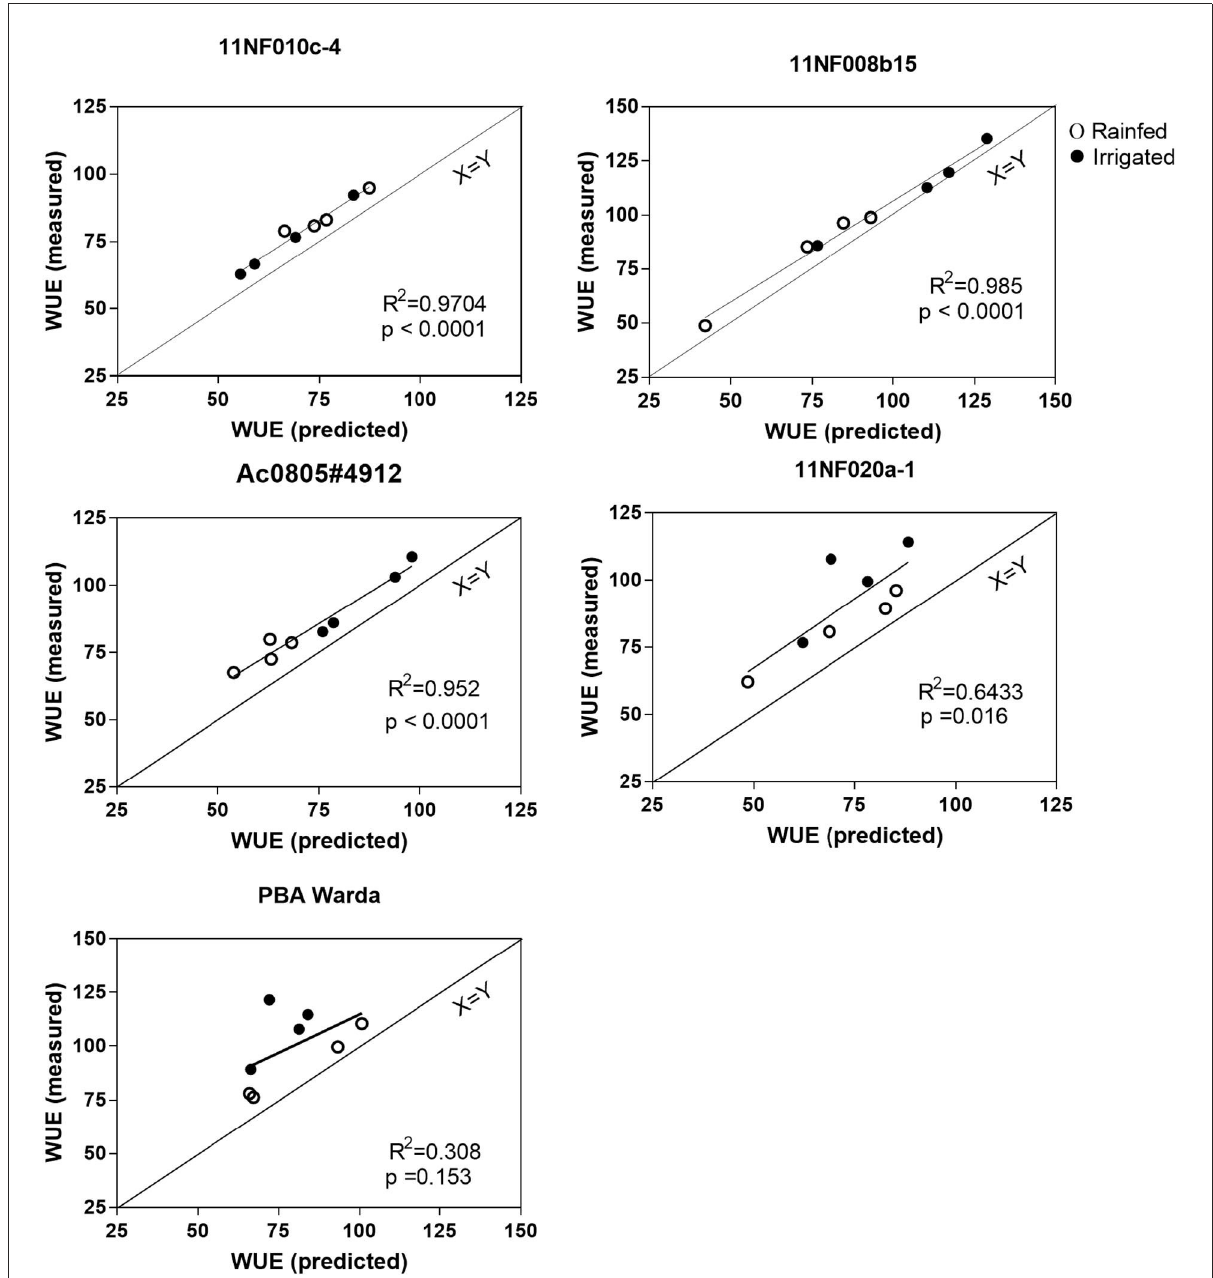
FIGURE7 Predicted water use efficiency vs. measured water use efficiency has grown in irrigated and rainfed conditions of contrasting faba bean genotypes. Water use efficiency was calculated according to the formula of Farquhar and Richards (1984) and Seibt et al. (2008). The measurement was completed at the three-pod stage; plant age was between 120 and 128